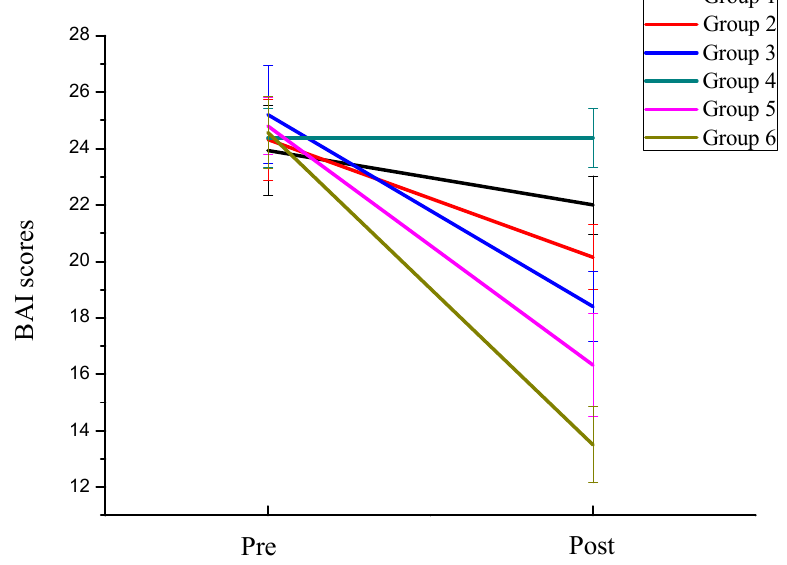
Figure 3. The trend of anxiety symptoms of the six groups of subjects.